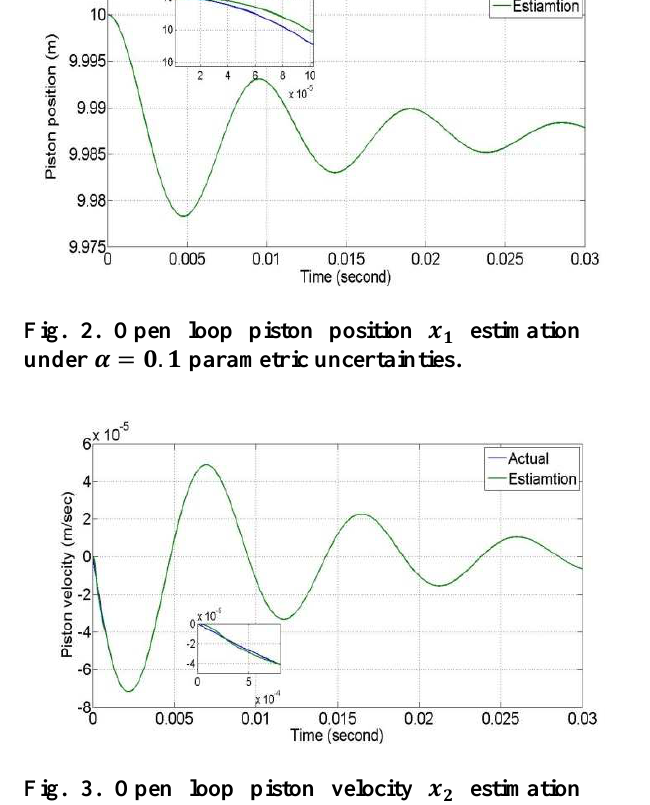
Fig. 3. Open loop piston velocity